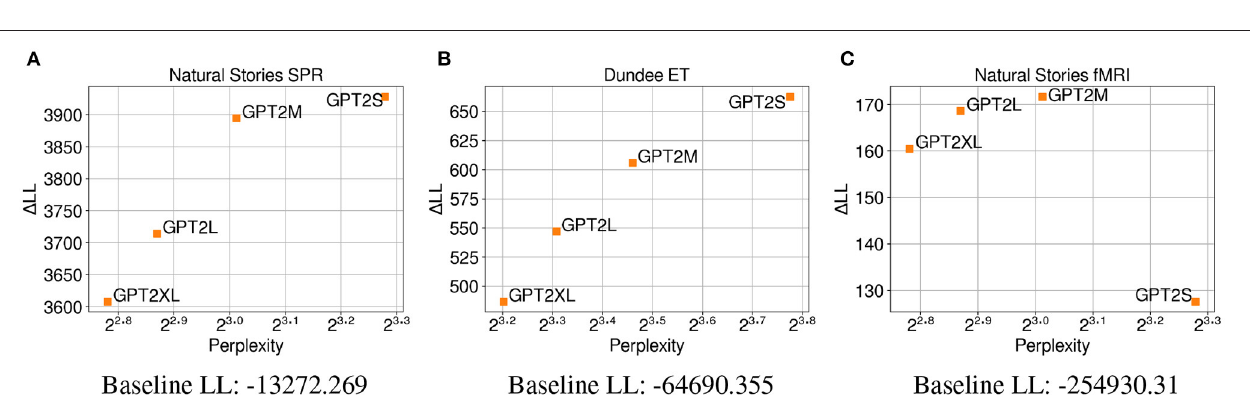
FIGURE 8 | Perplexity measures from each GPT-2 model, and improvements in CDR model log-likelihood from including each surprisal estimate on (A) Natural Stories self-paced reading data, (B) Dundee eye-tracking data, and (C) Natural Stories fMRI data. The difference in by-item squared error between the GPT2S and GPT2L models is significant at p < 0.05 level for the self-paced reading data, and the difference in by-item squared error between the GPT2S and GPT2M models is significant at p < 0.05 level for the eye-tracking and fMRI